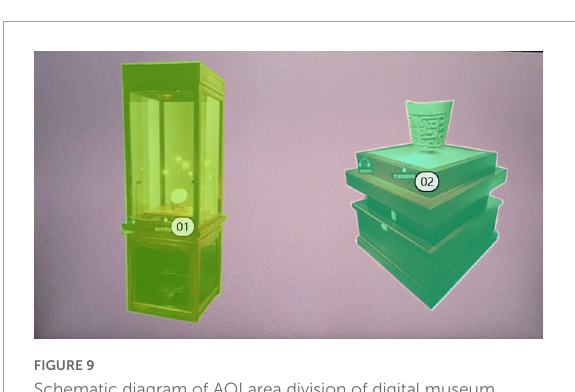
FIGURE9 Schematic diagram of AOI area division of digital museum showcase test